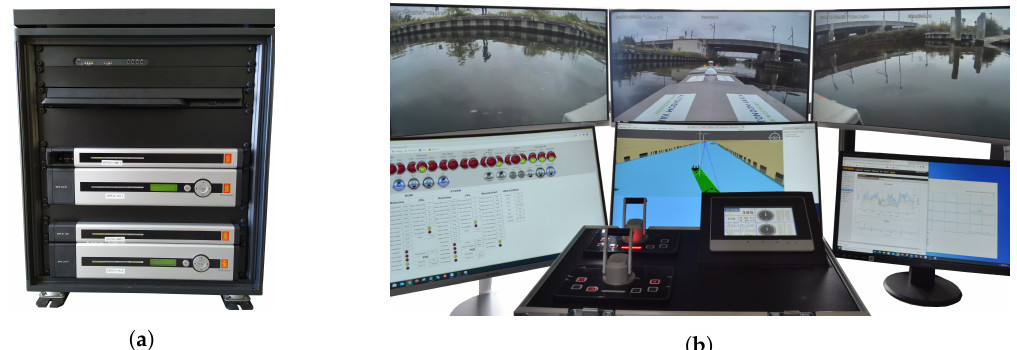
Figure 12. Current H2H-extended I-SCC configuration: ( a ) the combined H2H Engine, and ( b ) the H2H application running in the